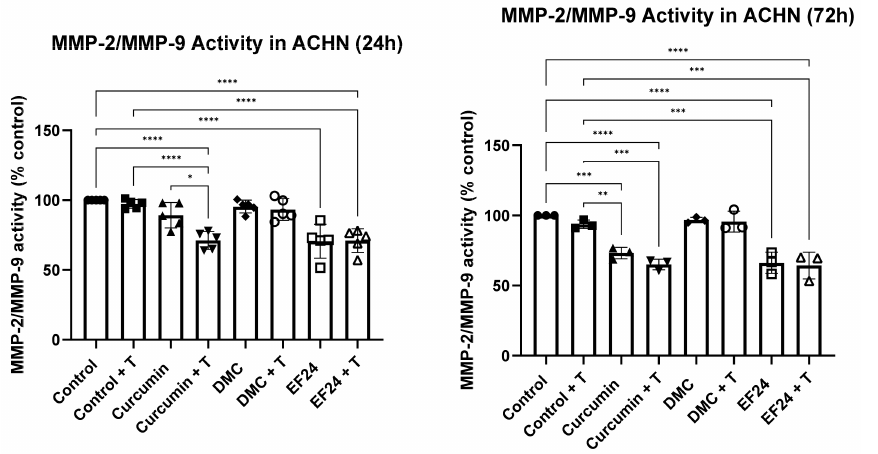
Figure 7. MMP-2/MMP-9 activity following 24 h and 72 h treatment of ACHN cells with curcumin, DMC or EF24 individually and in combination with TRAIL. Treatment with curcumin (89.27% at 24 h and 73.13% at 72 h) and EF24 (71.23% at 24 h and 65.04% at 72 h), both alone and in combination with TRAIL significantly reduced the activity of MMP-2 and MMP-9 (compared to control) at 24 h and 72 h, while treatment with DMC did not have an impact on the activity of these two proteins. Treatment with curcumin + T reduced the MMP-2/MMP-9 activity to 73.23% at 24 h and to 65.04% at 72 h and EF24 + T treatment reduced the MMP-2/MMP-9 activity to 66.21% at 24 h and to 64.31% at 72 h. n = 5 (24 h) and n = 3 (72 h). * p < 0.05, ** p < 0.01, *** p < 0.001, **** p <